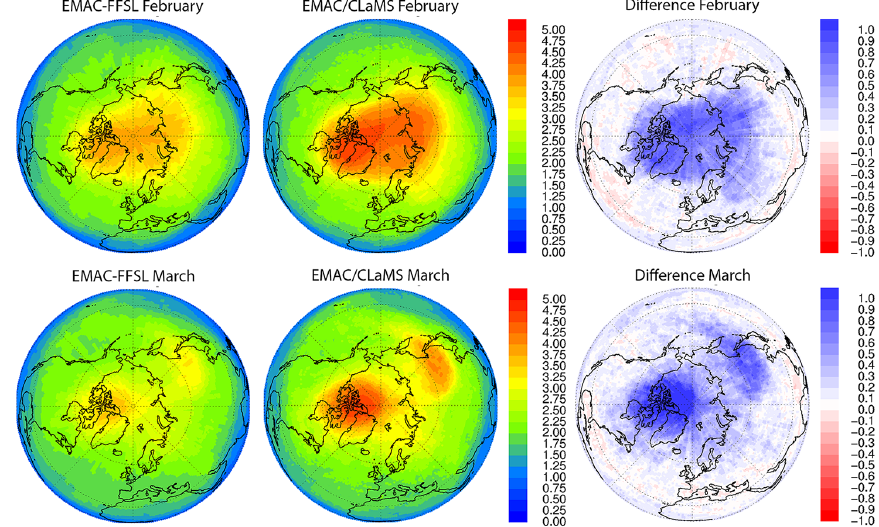
Figure 9. Age of air [years] at 450K for February (top panels) and March (bottom panels) in the Northern Hemisphere. Left and middle panels display age of air distributions for EMAC-FFSL and EMAC/CLaMS, respectively. Right panels show the absolute difference in mean age of air [years] (EMAC/CLaMS − EMAC-FFSL). Blue colour denotes older air in EMAC/CLaMS, and red colour denotes older air in